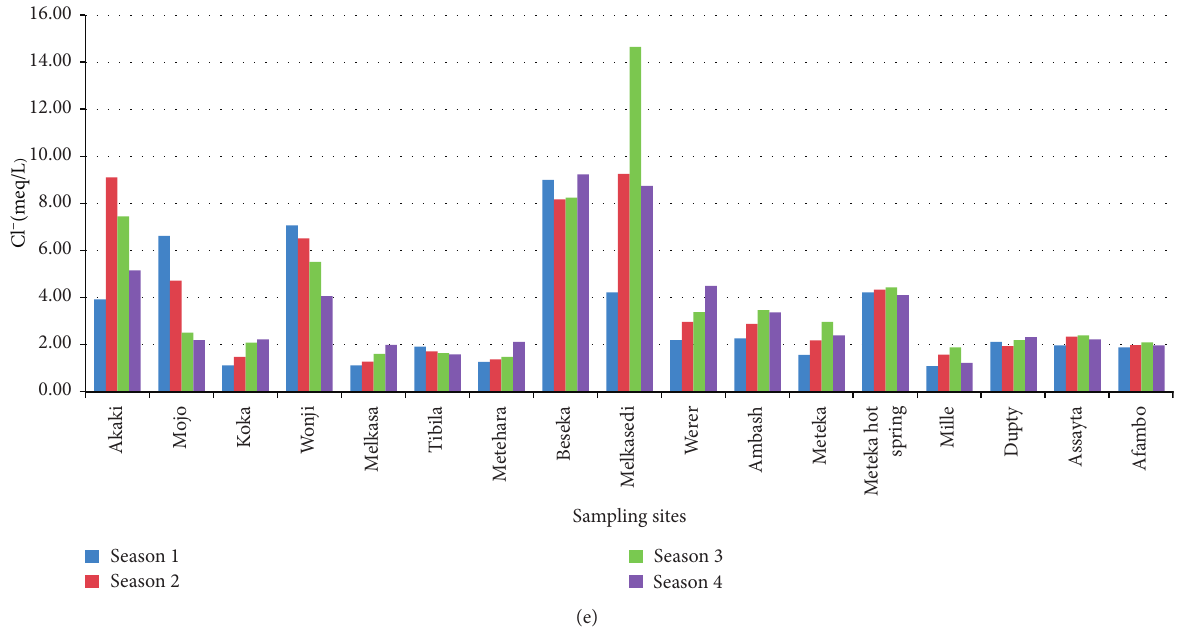
Figure 4: Mean seasonal variation of RSC across different locations over years